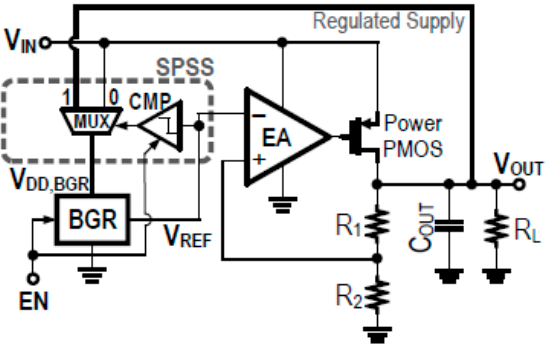
Figure 33. Bandgap Reference-based Hybrid LDO [60].